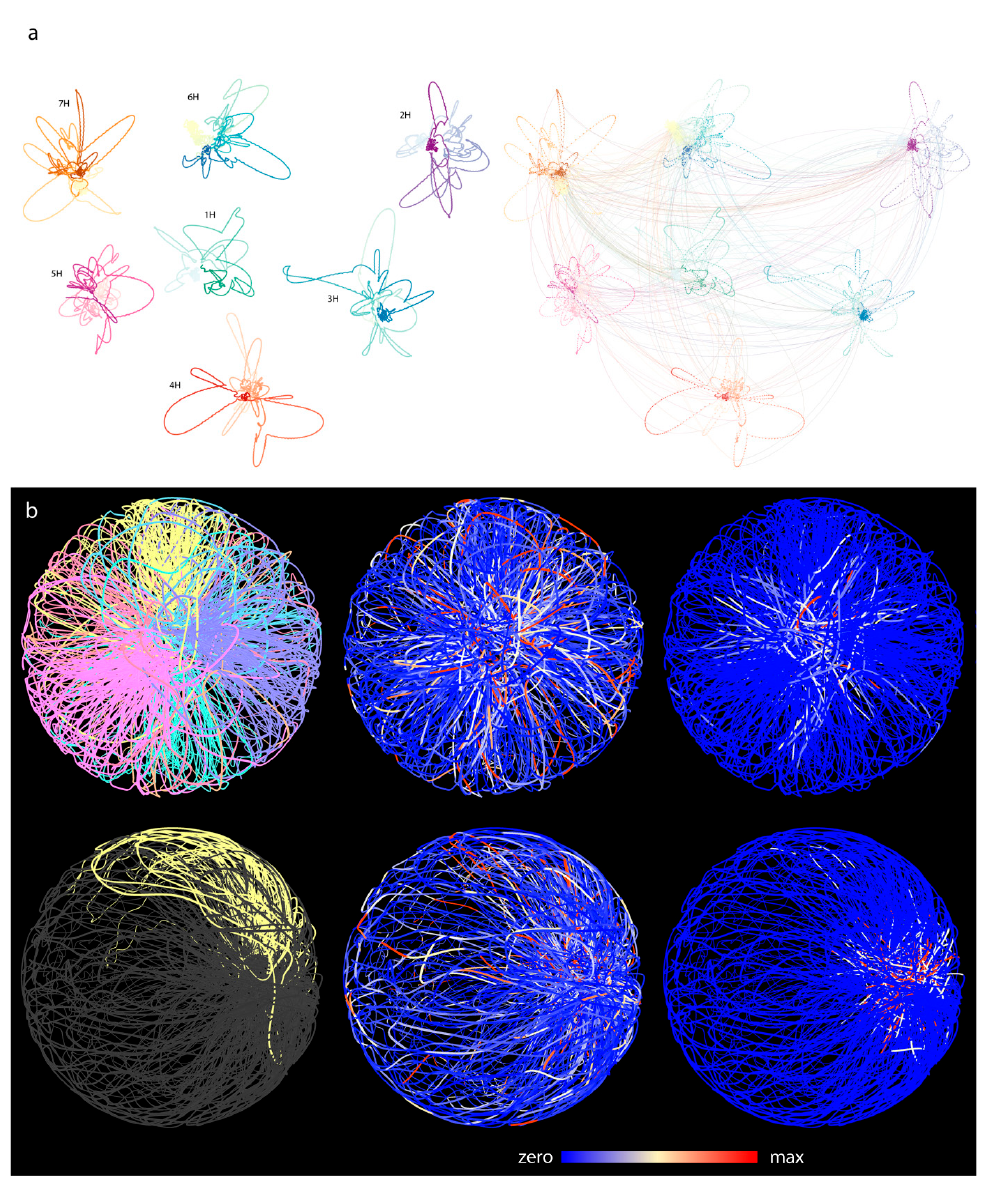
Figure 4. Going from 2D contact graph to multigraph model of 3D genome of barley. ( a ) Two-dimensional layouts of the multigraph of each barley chromosomes. Layout was calculated based on